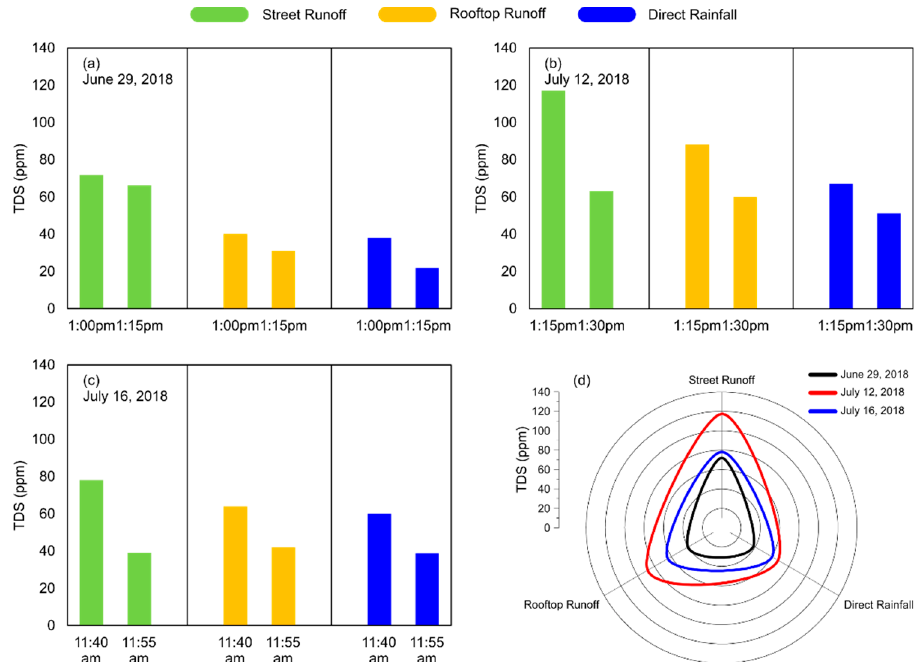
Figure 4. Profile of total dissolved solids (ppm) in harvested rainwater at Site S1—Irrigation Research Institute, Irrigation Department, Lahore, Pakistan, where ( a ) represents 29 June 2018, ( b ) represents 12 July 2018, ( c ) represents 16 July 2018, and ( d ) illustrates comparative analysis of the three selected dates on polar chart.